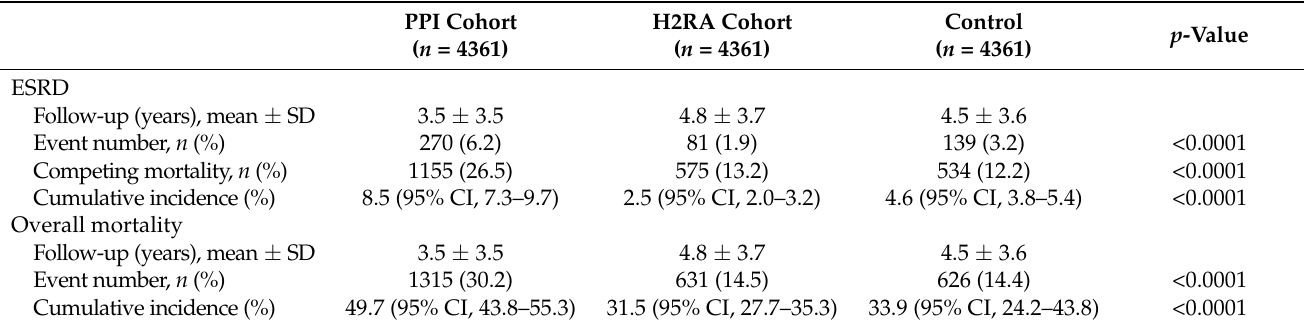
Table 3. End-stage renal disease (ESRD) occurrence and overall mortality over a 15-year follow-up period. PPI